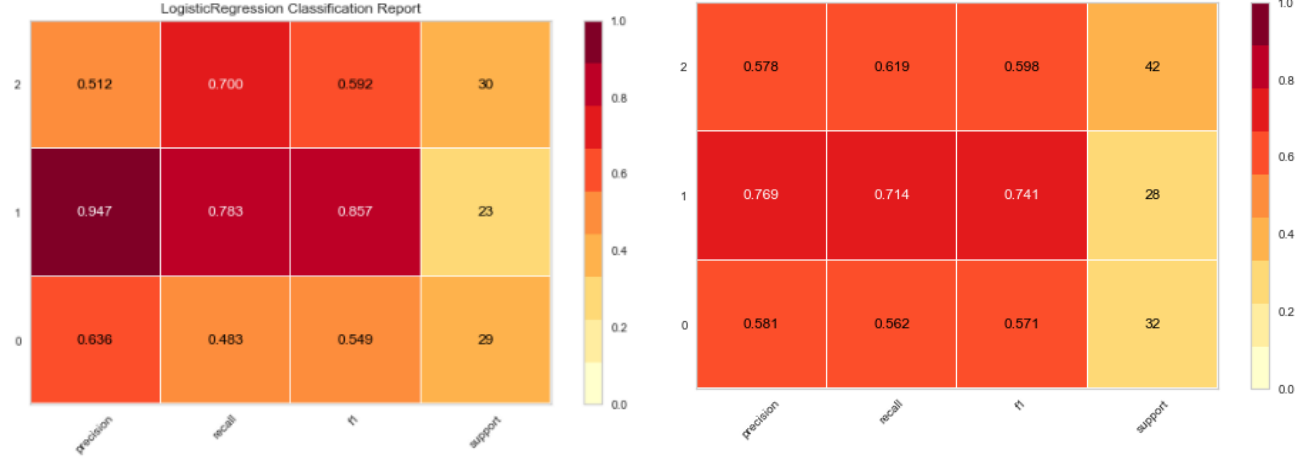
Fig. 16. Classification report for